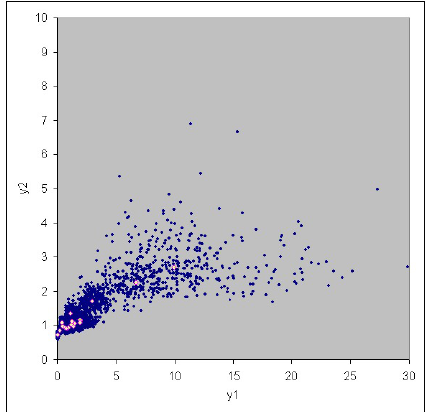
Figure 10. Simulation scatterplot of ˆ g ( y 1 , y 2 ) , m = 50. Large scale.